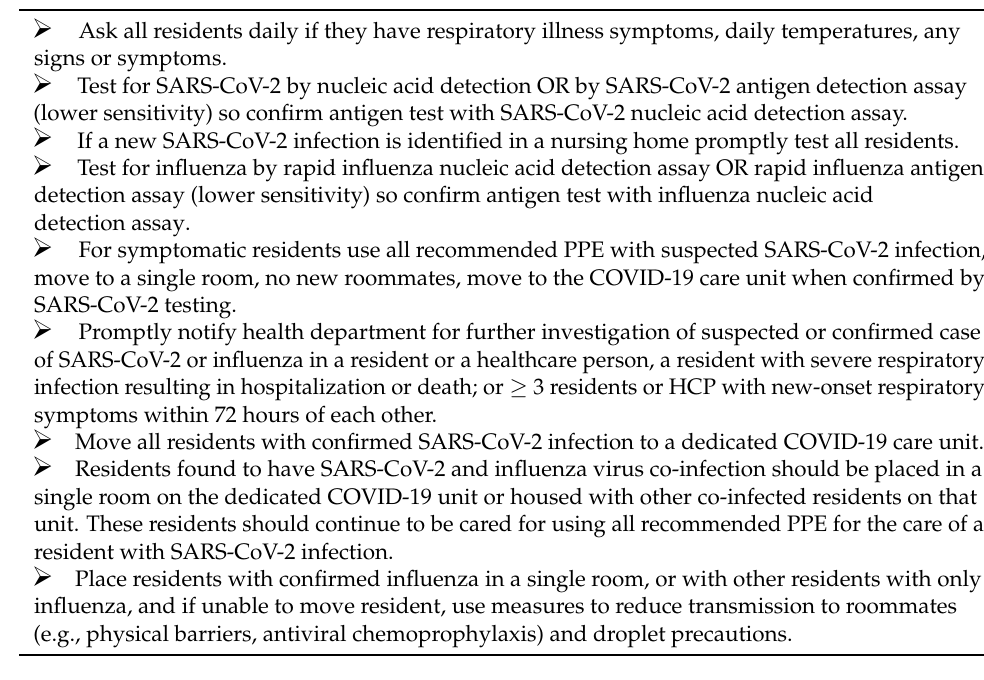
Table 6. CDC recommendations for nursing home residents with acute respiratory illness symp- toms when SARS-CoV-2 and influenza viruses are circulating. ➢ Ask all residents daily if they have respiratory illness symptoms, daily temperatures, any signs or symptoms.